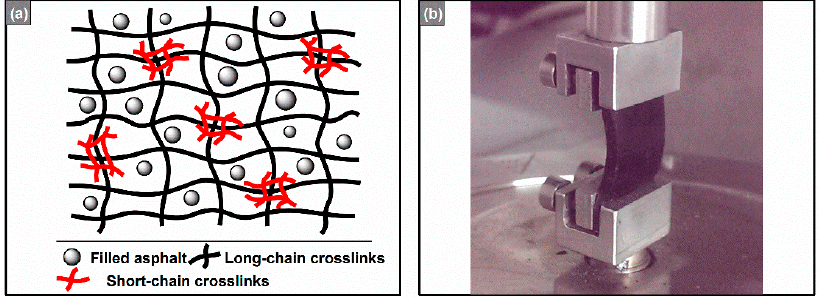
Figure 1. ( a ) Schematic diagram of bimodal networks; ( b ) Customized SRF5 solid torsion geometry.